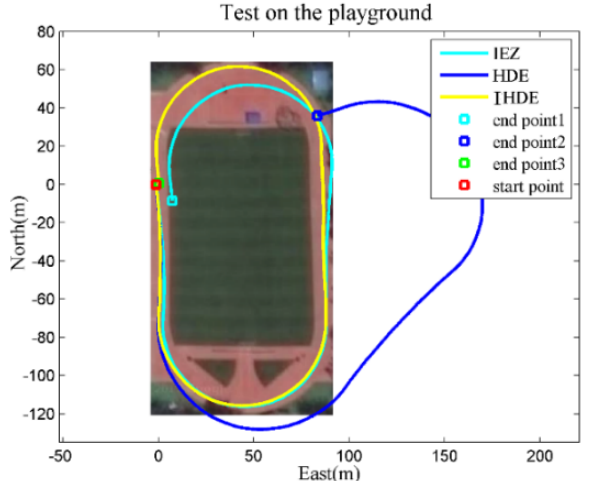
Figure 8. Starting somewhere on the outside straight, the person was asked to walk along the track and return to the starting point, and the entire path was approximately 455